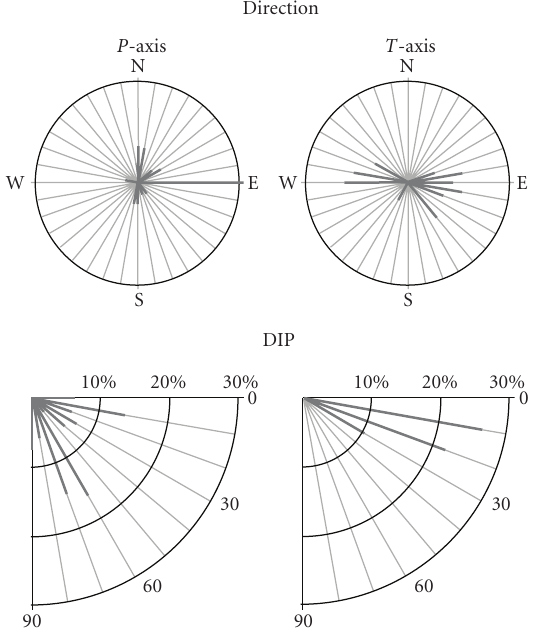
Figure 5: Statistical charts of azimuths and dips of compressive (P) and extensional (T) axes in the southern and central part of the Tibetan plateau (AB region in Figure 2).